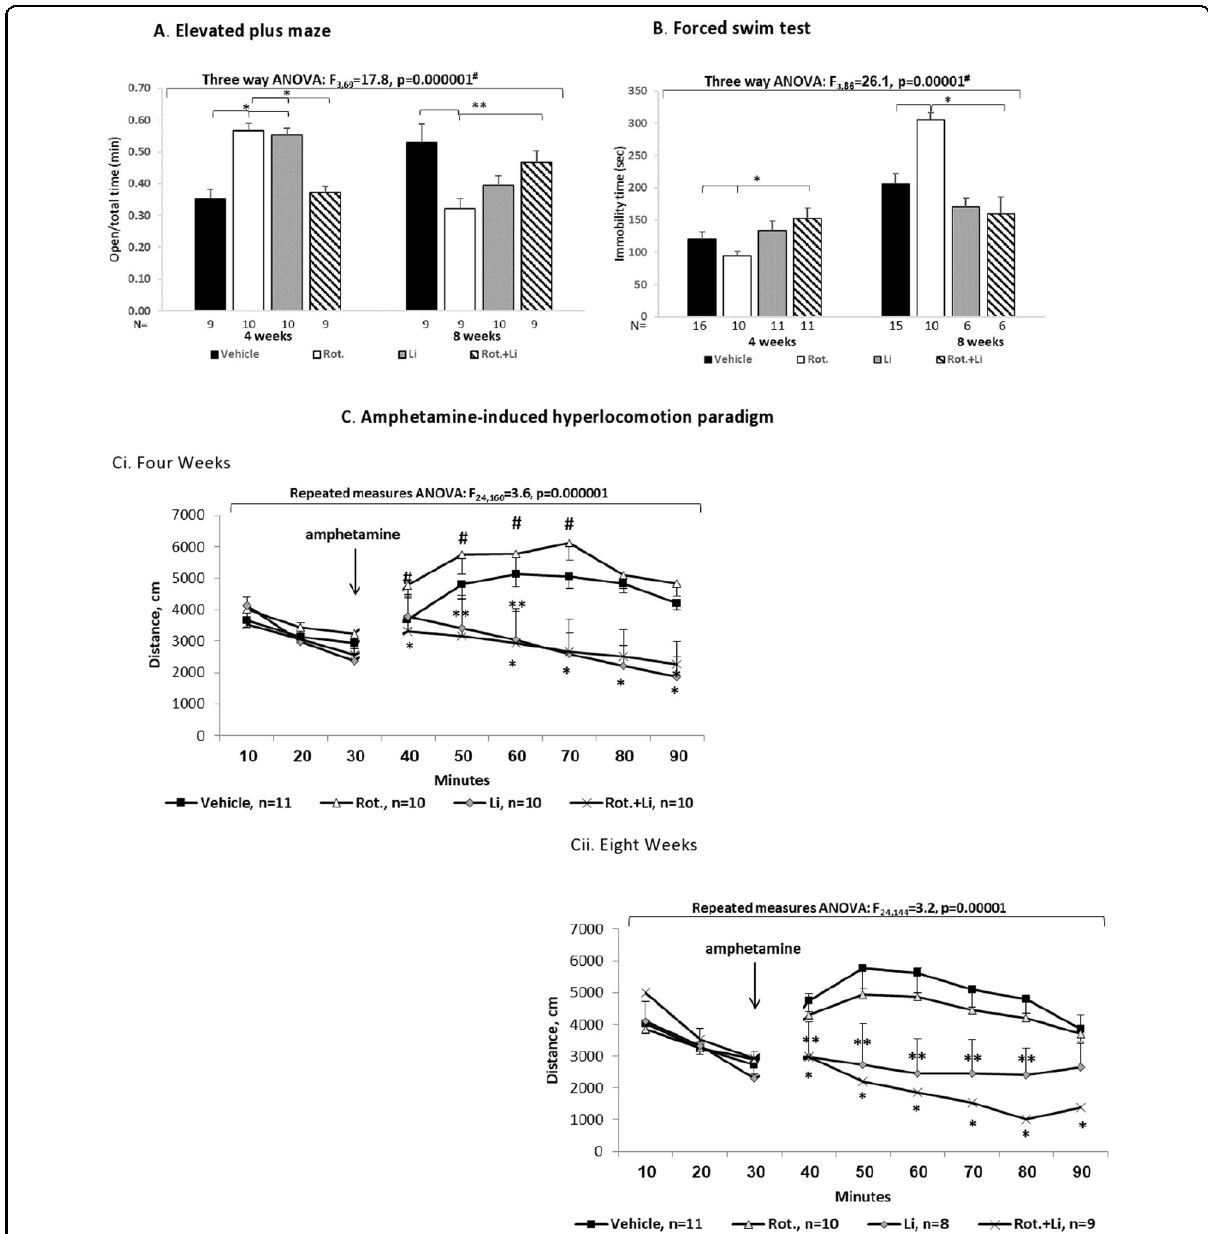
Fig. 3 Behavioral consequences of in vivo rotenone-induced mild mitochondrial dysfunction in mice and their reversal by lithium treatment. 0.75mg/kg/day rotenone (Rot.) was administered i.p. for 4 or 8 weeks. Lithium (Li) was given for the last 2 weeks of rotenone treatment. Results represent means± SEM of three independent experiments with at least three mice/group in each experiment. In each test (EPM, FST and amphetamine-induced hyperlocomotion) one result exceeding ±2SDs was excluded. A The effect on the behavior in the EPM. Time in the open arms/ total time was increased by Rot. following 4 weeks and reduced following 8 weeks of treatment. Three-way ANOVA with treatment (± Rot.), Li (±) and duration of treatment (4/8 weeks) as main factors: # values are of the TreatmentXLiXDuration interaction; *Fisher ’ s LSD post hoc test: 4/8 weeks Rot. or Li vs. vehicle and vs. Rot. + Li, p < 0.04. B The effect on the behavior (immobility time) in the FST. Three-way ANOVA with treatment (± Rot.), Li (±) and duration of treatment (4/8 weeks) as main factors: # values are of the TreatmentXLiXDuration interaction; *Fisher ’ s LSD post hoc test: 4/8 weeks Rot. vs. vehicle and vs. Rot. + Li, p < 0.03. C The effect in the amphetamine-induced hyperlocomotion paradigm. Ci. Repeated measures ANOVA of the results following amphetamine injection revealed that Rot. signi fi cantly augmented the effect of amphetamine ( # Fisher ’ s LSD post hoc test, p < 0.03). Li by itself signi fi cantly reversed amphetamine ’ s effect (** p ≤ 0.03) and totally reversed the effect of Rot. on amphetamine-induced hyperlocomotion (* p <0.003). Cii. Repeated measures ANOVA of the results following amphetamine treatment revealed that Li by itself signi fi cantly reversed amphetamine ’ s effect (** p ≤ 0.05) and totally abolished amphetamine-induced hyperlocomotion (* p